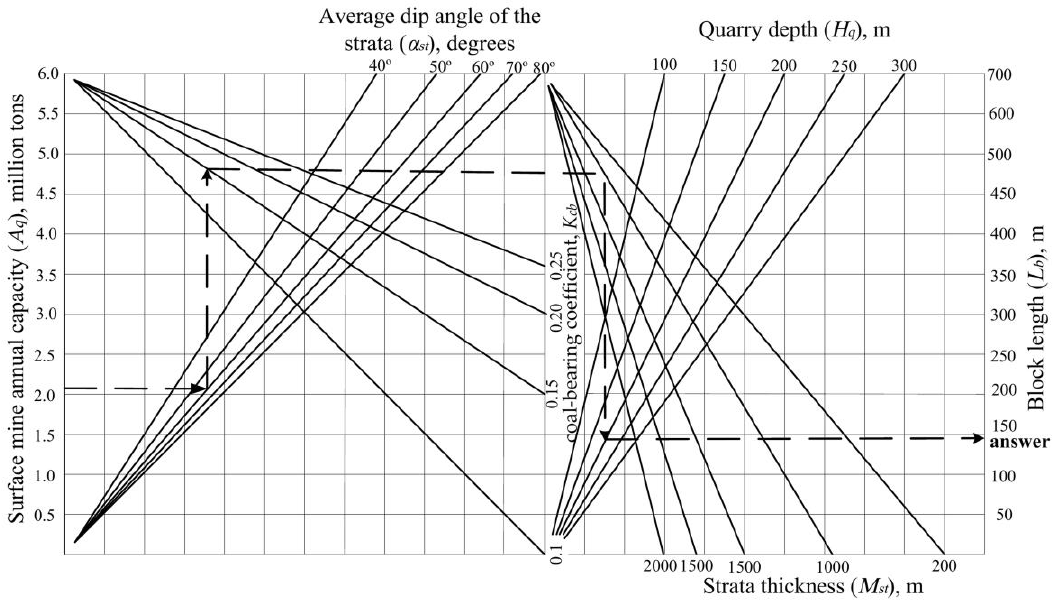
Table 1. Length of the exit L e for di ff erent layer’s height h l and backhoe’s bucket